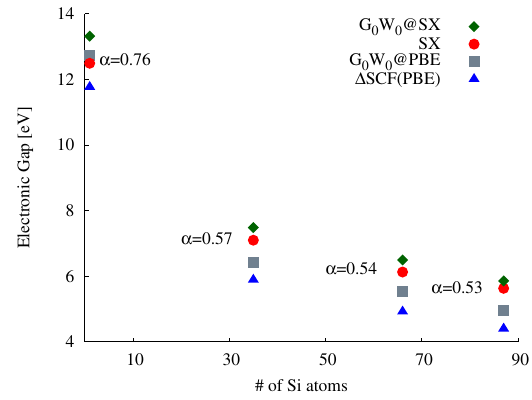
FIG. 2. The fundamental gaps of several hydrogen passivated silicon nanostructures SiH 4 , Si 35 H 36 , Si 66 H 64 , and Si 87 H 64 predicted using the SX hybrid functional (see text), G 0 W 0 starting from PBE wave functions (G 0 W 0 @ PBE), and SX wave functions (G 0 W 0 @ SX). Fundamental gaps obtained from total energy differences [ Δ SCF ð PBE Þ ] are included for comparison.